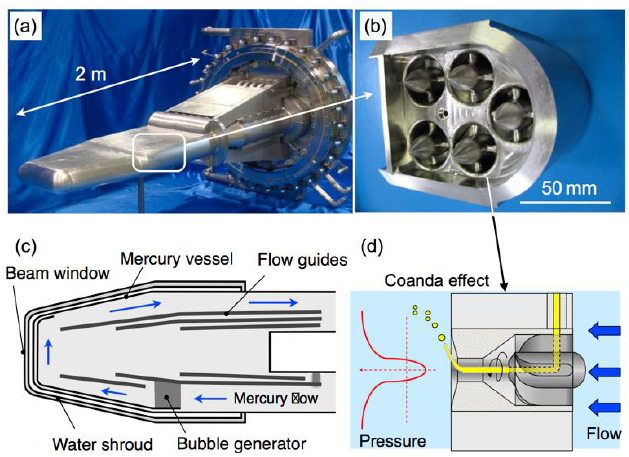
Figure 3. Photographs of target vessel ( a ) and bubble generator assembly ( b ), and their schematic views ( c ) and ( d ).